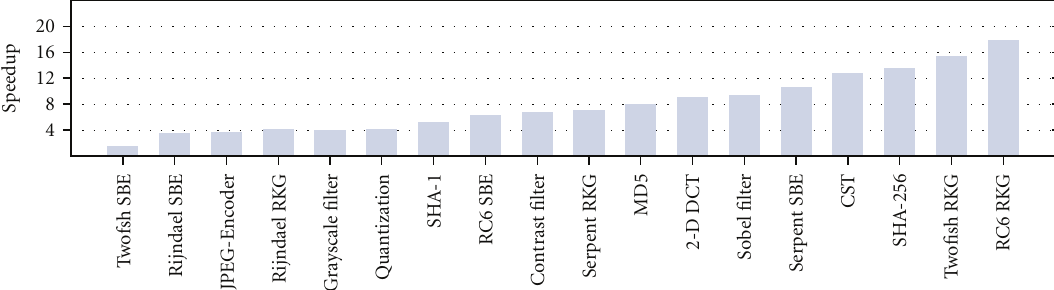
Figure 8: Diagram of runtime acceleration of benchmark